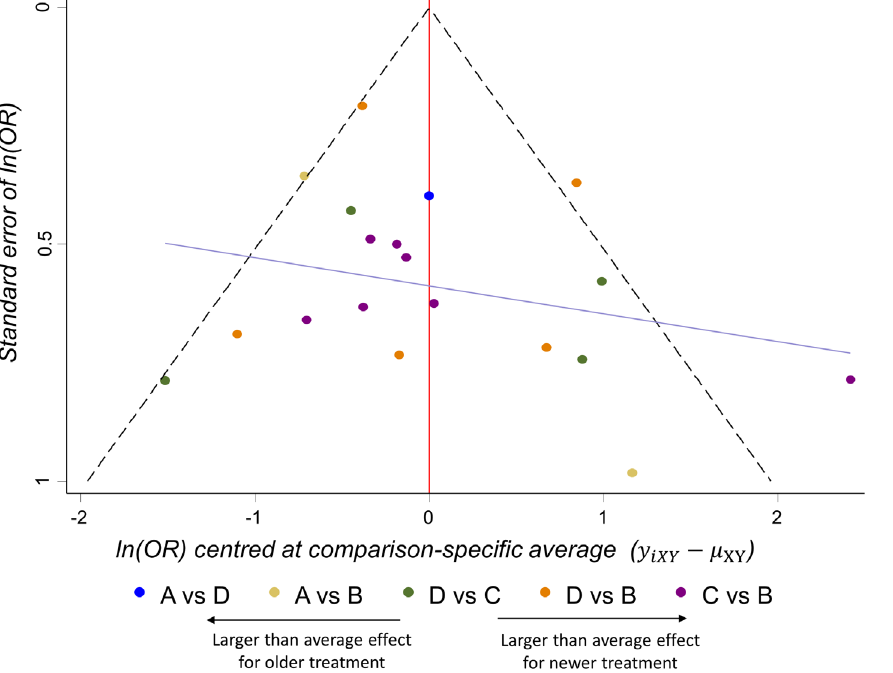
Figure 7. Comparison-adjusted funnel plot for the network of topical antibiotics without steroids for chronically discharging ears. Each observation is the difference between a study estimate and its direct meta-analysis mean effect. Studies on the right hand side ‘overestimate’ the effect of newer treatments.